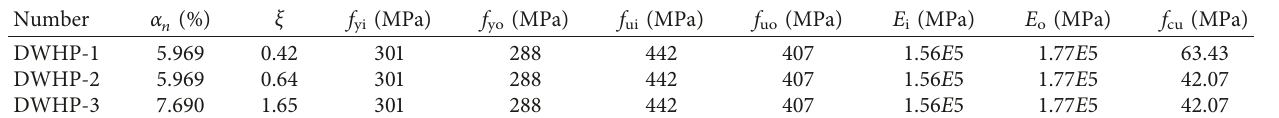
Table 2: Material performance parameters of